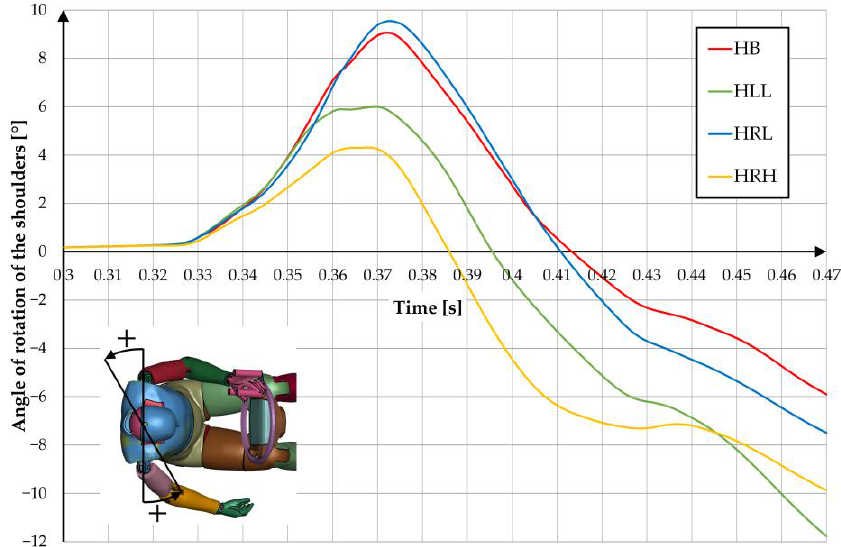
Figure 12. Angle of rotation of the shoulders.